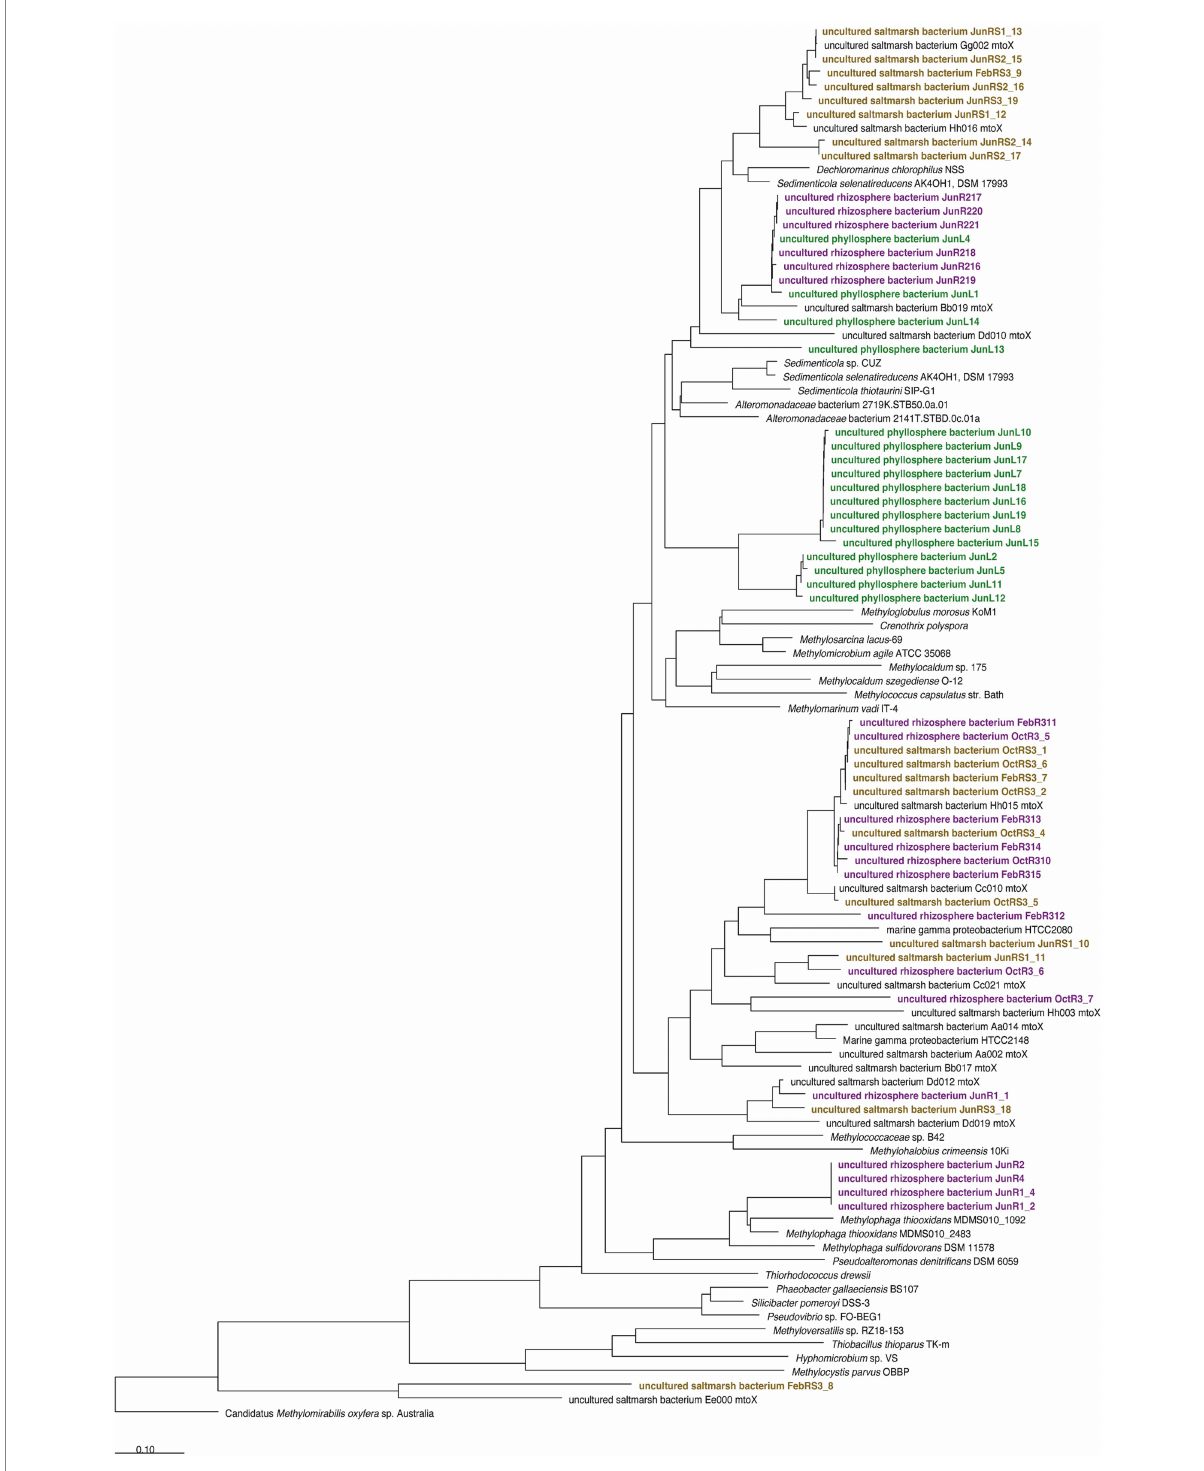
FIGURE 6 Diversity of methanethiol oxidase containing microorganisms associated with Sporobolus anglicus based on analysis of translated amino acid sequences derived from cloned mtoX amplicons. Sequence labels are coded according to time of sampling (February 2012; June and October 2013, respectively) and origin of sequences (RS, rhizosphere sediment, brown; R, root, purple; and L, leaf, green). The tree was obtained by Neighbour-Joining analysis in ARB based on an amino acid sequence alignment and the use the MtoX sequence of Hyphomicrobium sp. VS as a filter. A distance correction using the PAM matrix was used as implemented in ARB. The final dataset contained 204 valid alignment columns (positions 98–301 of the Hyphomicrobium sp. VS MtoX